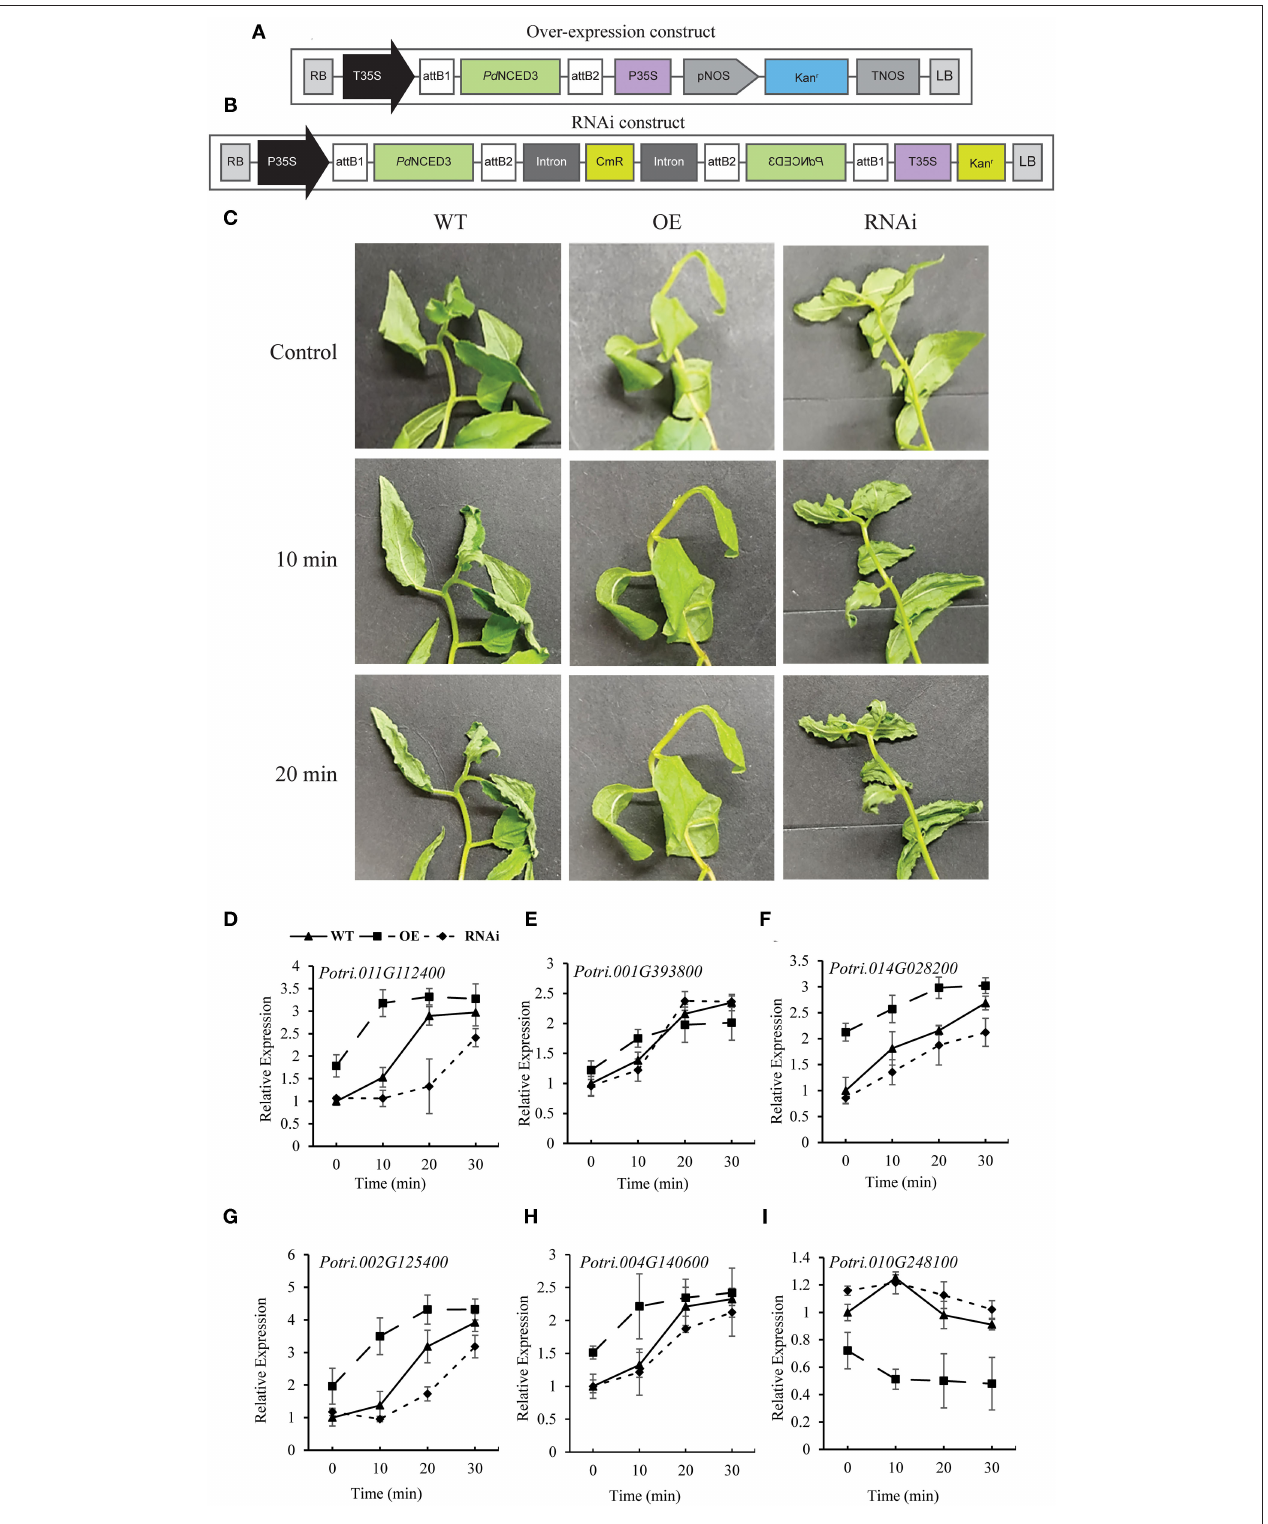
FIGURE 8 | DNA constructs for generating transgenic lines and the response of transgenic lines to dehydration. The DNA constructs for generating NCED3 overexpression (OE) (A) and knock-down RNA interference (RNAi) lines (B) . The leaves from the OE and RNAi transgenic lines were detached and allowed to sit for up to 20min at room temperature (C) . qRT-PCR analysis showing the expression of NCED3 (D) , NCED1 (E) , and multiple transcription factor genes involved in ABA-dependent drought stress responses (F–I) . Each data point in the graphs represents the mean of at least three replicates. Error bars indicate SD.